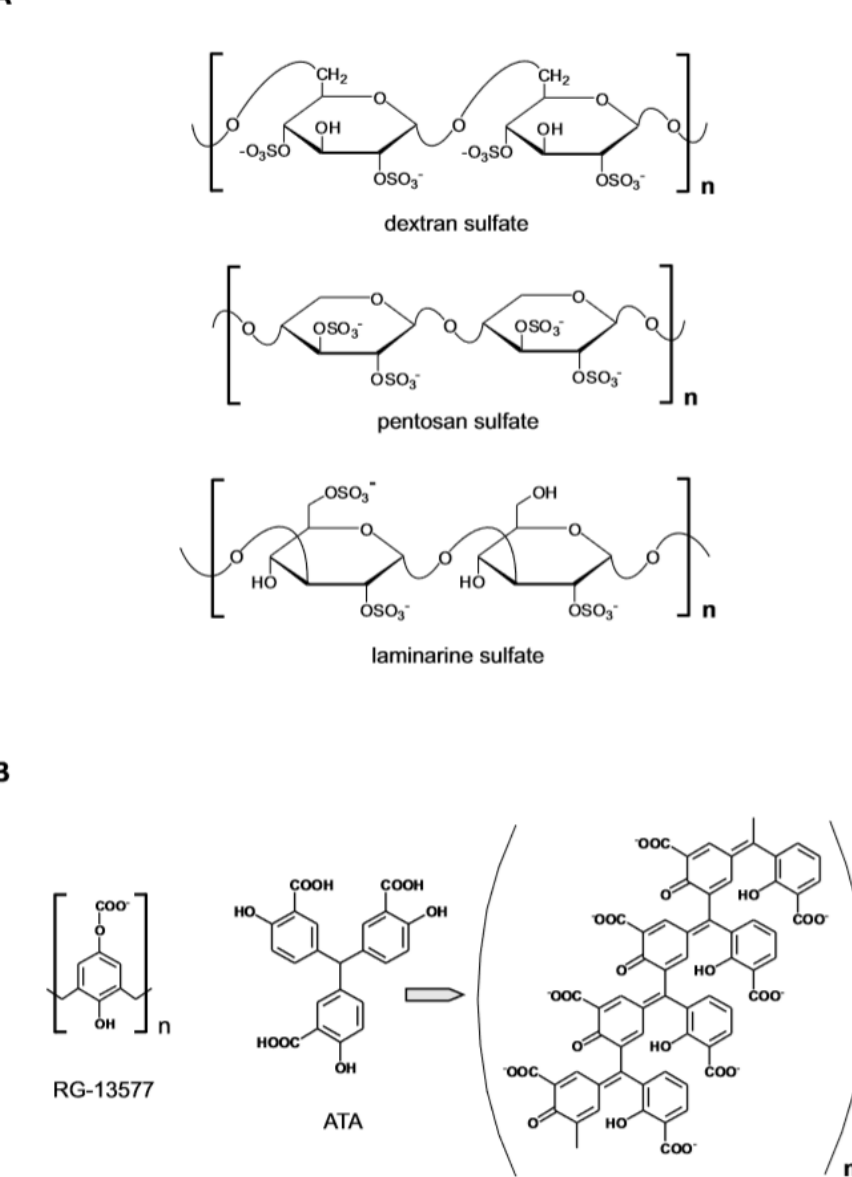
Figure 1. Anionic polymers as heparin-mimetic. ( A ) Polysulfated polymers based on a carbohydrate backbone. ( B ) Fully synthetic polycarboxylic polymers.